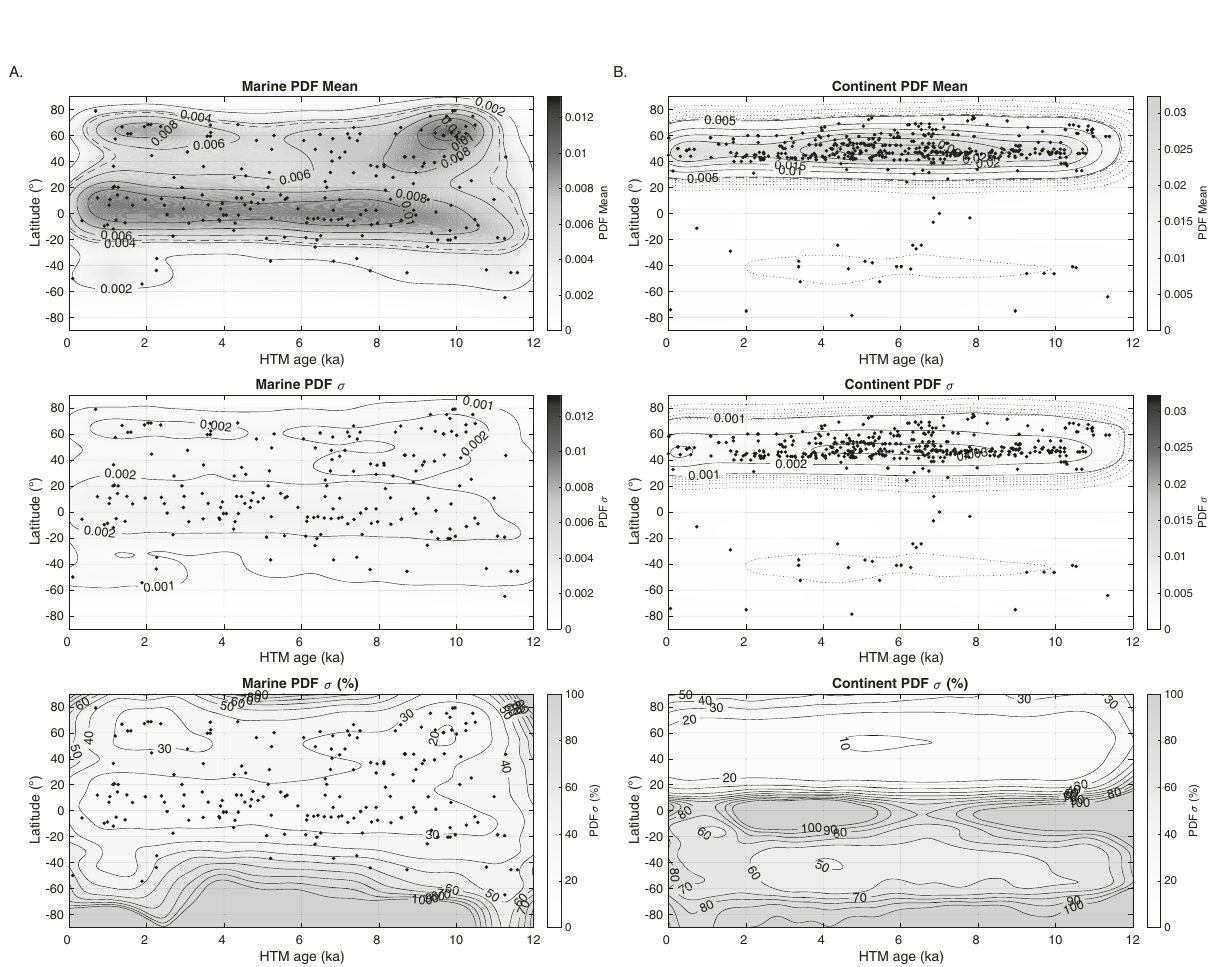
Fig. 5 | Robustness of the spatiotemporal structure of the Holocene Thermal Maximum. Robustness of the spatiotemporal structure of the Holocene Thermal Maximumformarine( A )and continental( B )temperatureproxyensembles.Mean,